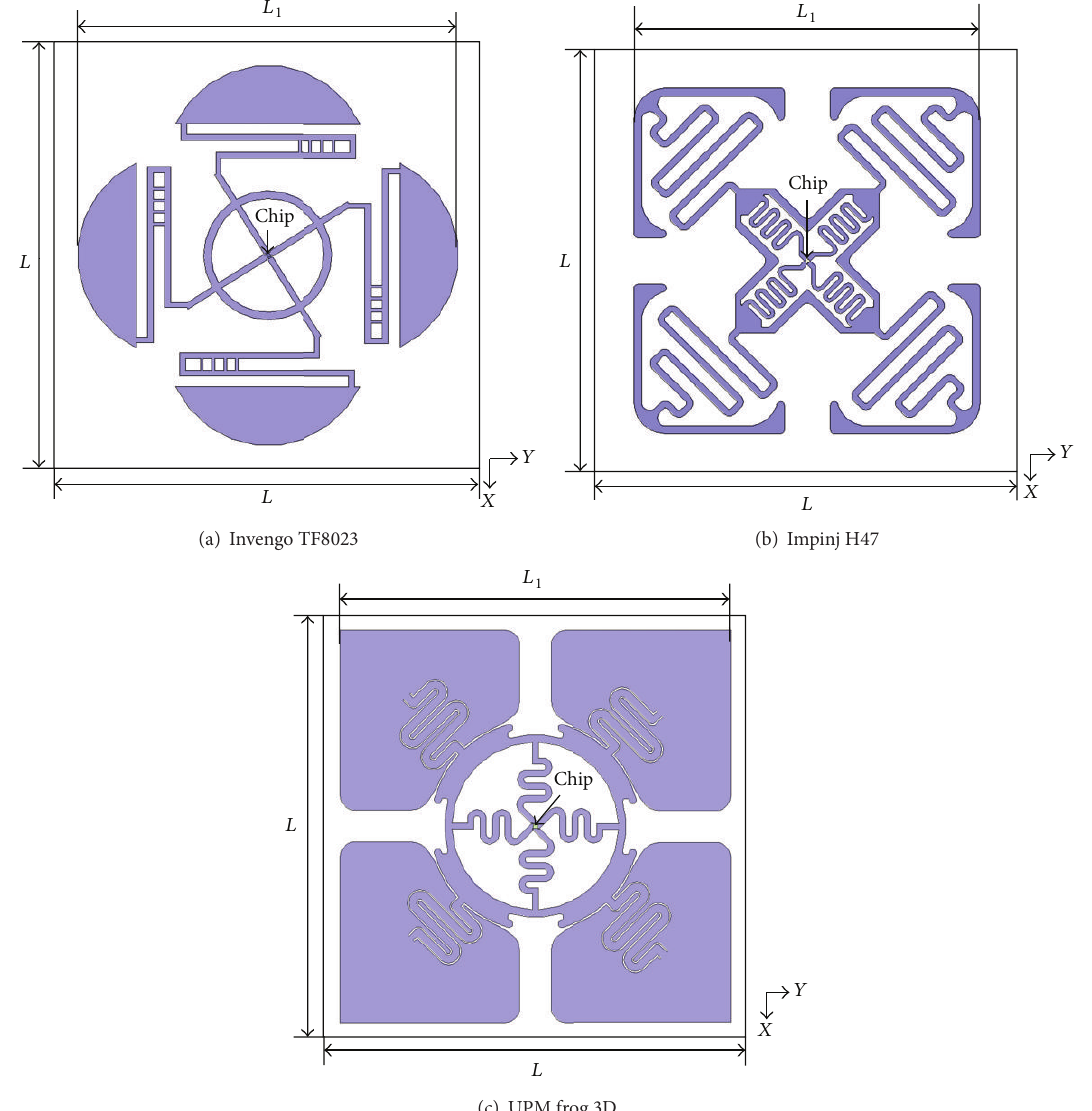
Figure 8: Structure of the three commercial tag antennas. The area of substrate is 𝐿 × 𝐿 , the material of substrate is PET, and the area of antenna radiator is 𝐿 1 × 𝐿 1 .